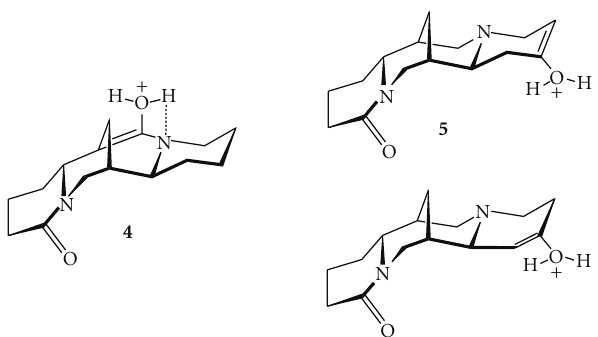
fragment ion [M+H-H 2 O] + c [C 15 H 20 N 2 O+H] + at m/z 245 in the FAB spectrum of 5